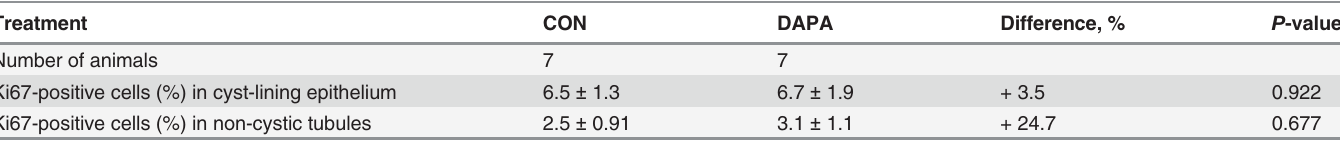
Table 5. Effect of DAPA on cell proliferation in PCK rat kidneys.